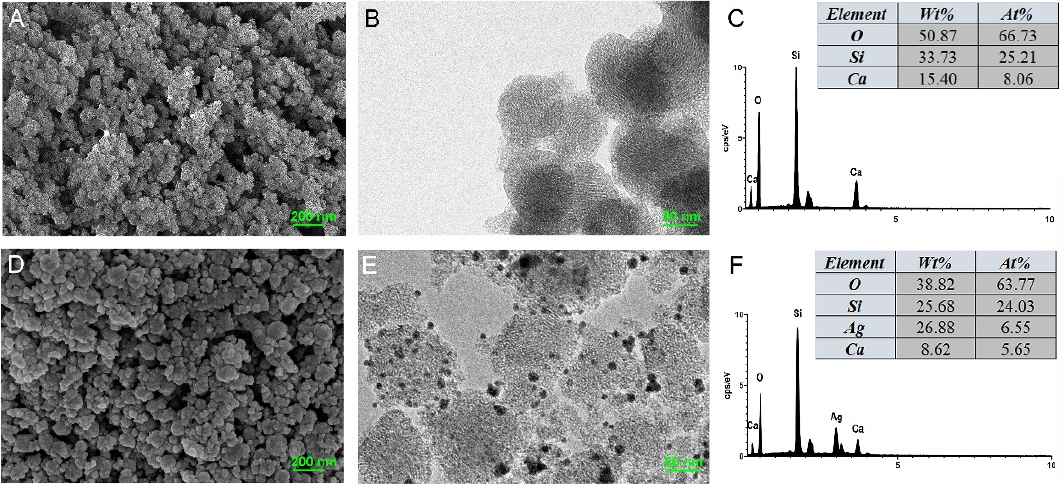
Figure 1. Characterization of MCSNs and M-AgTX. ( A , D ) Representative images of MCSNs and M-AgTX by FE-SEM; ( B , E ) Representative images of MCSNs and M-AgTX by TEM; ( C , F ) Representative images of MCSNs and M-AgTX by EDS.